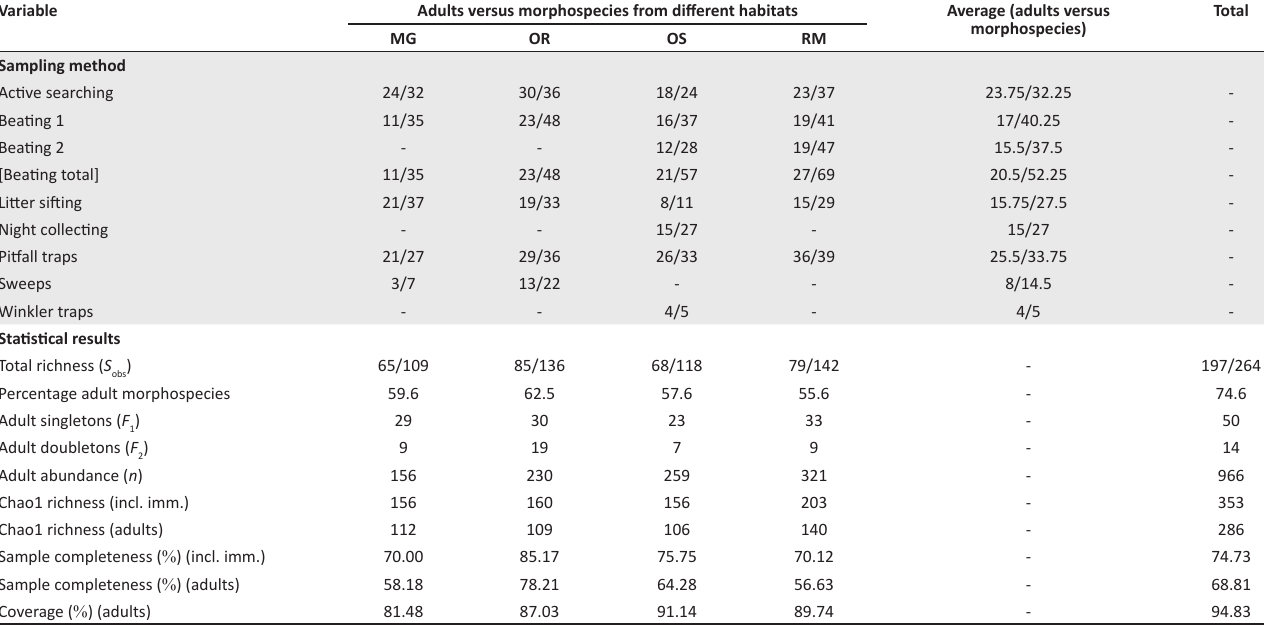
TABLE 1: Arachnid species richness (adult morphospecies vs total morphospecies, including immatures) sampled using seven methods during the SANSA II field survey in the Ophathe Game Reserve in KwaZulu-Natal, October 2008. Variable